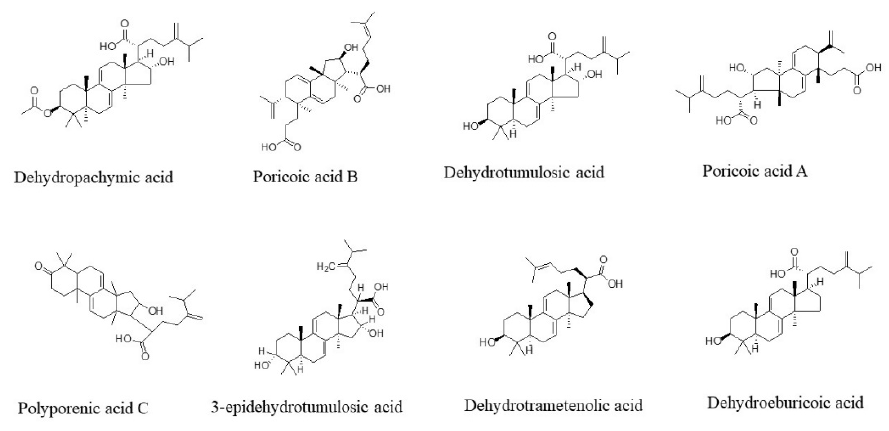
Figure 2. The representative HPLC chromatograms of the standards ( a ) and samples ( b ): 3, poricoic acid B; 4, dehydrotumulosic acid; 5, poricoic acid A; 6, polyporenic acid C; 7, 3-epidehydrotumulosic acid; 12, dehydropachymic acid; 14, dehydrotrametenolic acid; 15, dehydroeburicoic acid. However, the chemical structure of the remaining compounds 1, 2, 8, 9, 10, 11, 13 are uncertain.